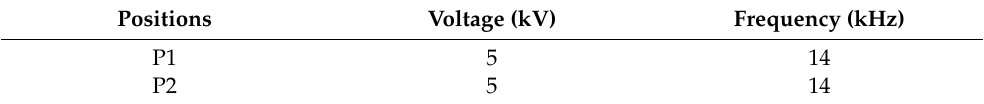
Table 6. Parameters of different actuation positions with 10 mm actuation length on inner surface.